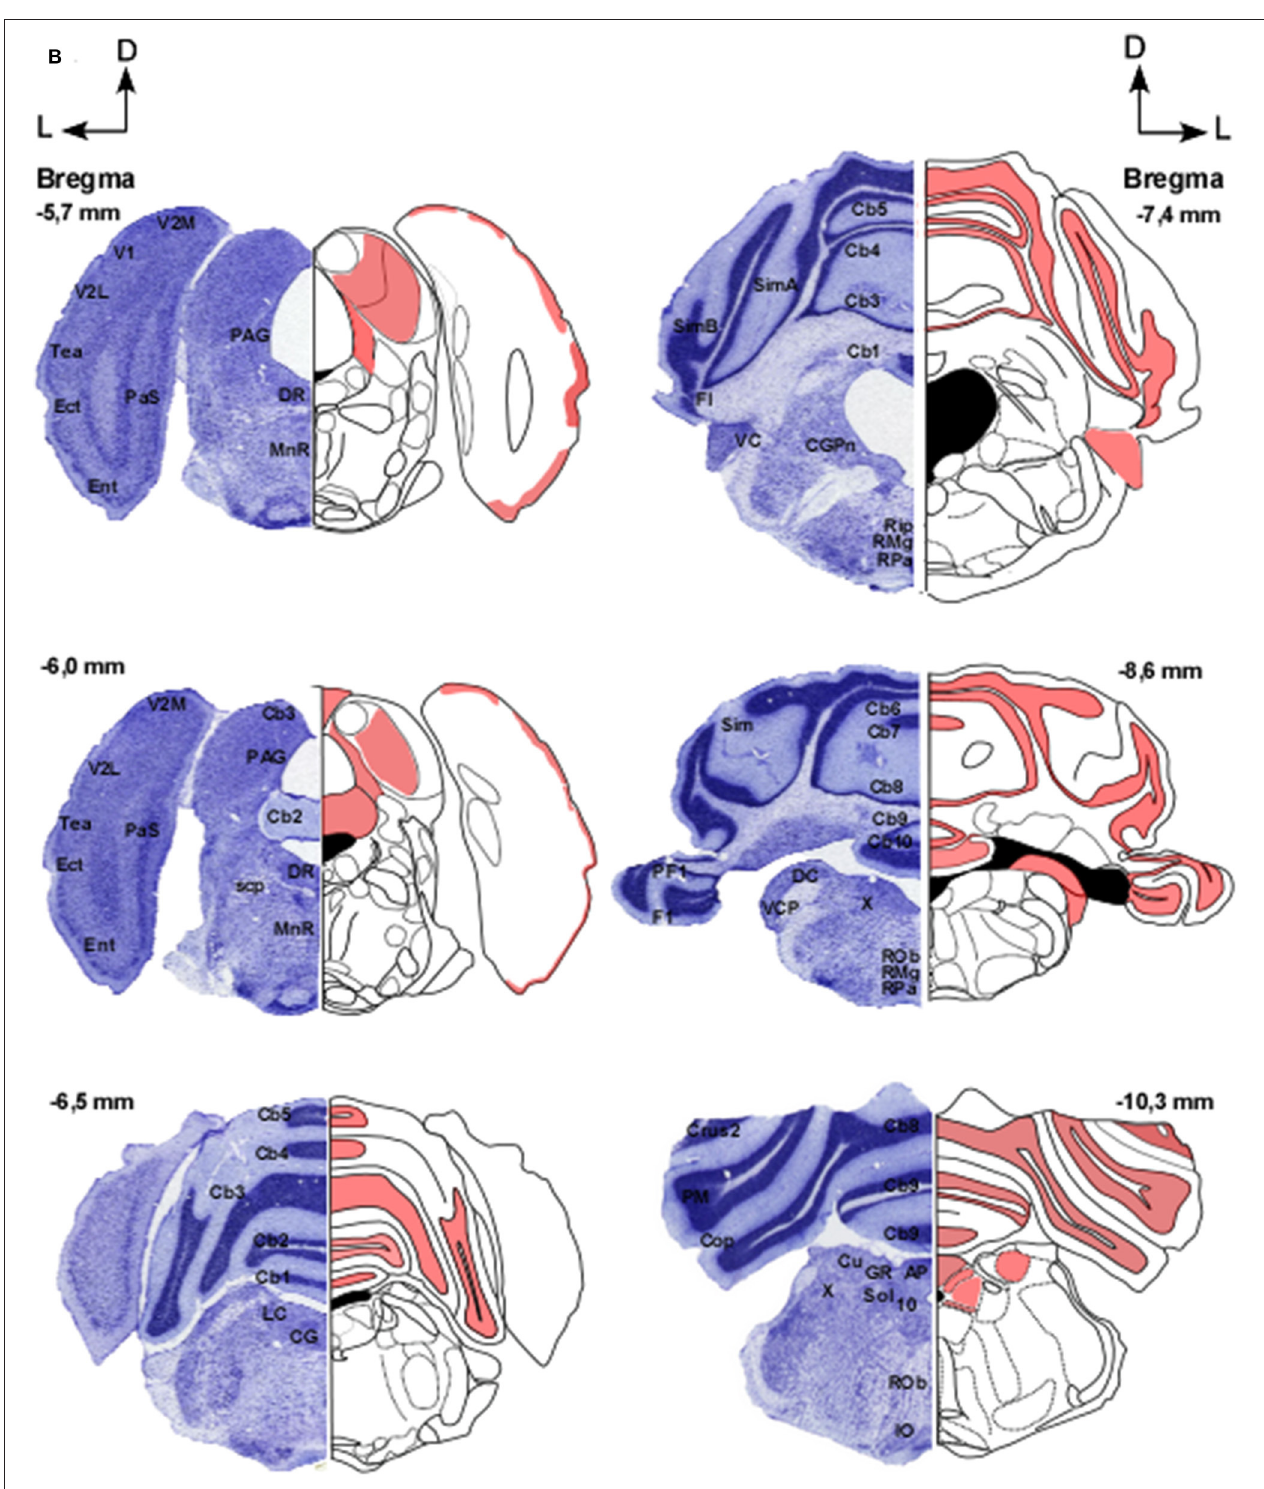
FIGURE 2 | (A,B) Distribution pattern of CB1 receptors in the brain of GASH/Sal. Schemes showing the coronal sections of the brain at different rostro-caudal levels (referenced with respect to Bregma), according to a stereotaxic atlas of the golden hamster brain. The distribution of CB1 receptors in the GASH/Sal is shown in red. Each coronal section includes a semi-section contrasted with Nissl staining as a cytoarchitectural reference of the different nuclei. 10, Dorsal motor nucleus of the vagus; aca, Anterior commissure, anterior part; AcbC, Accumbens nucleus, core; aci, Anterior commissure, intrabulbar part; ACo, Anterior cortical